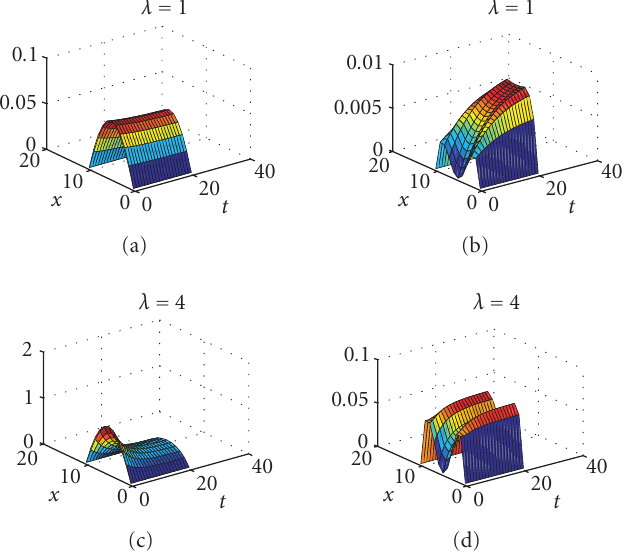
Figure 4.7. The lower solutions w ( x , t ) and v ( x , t ) and the di ff erence v ( x , t ) − w ( x , t ) for the slab ge- ometry, when β = 0 . 5, δ = 0 . 1, and λ =